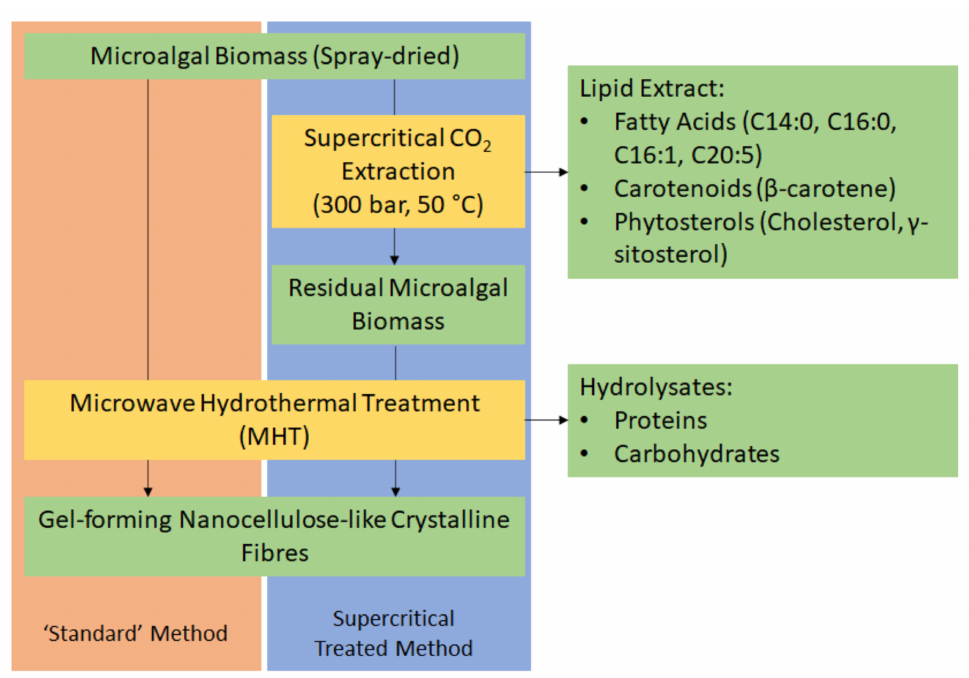
Figure 1. Process flow diagram of a potential biorefinery route of microalgal biomass. NB. ‘Standard’ refers to without any scCO 2 pretreatment.